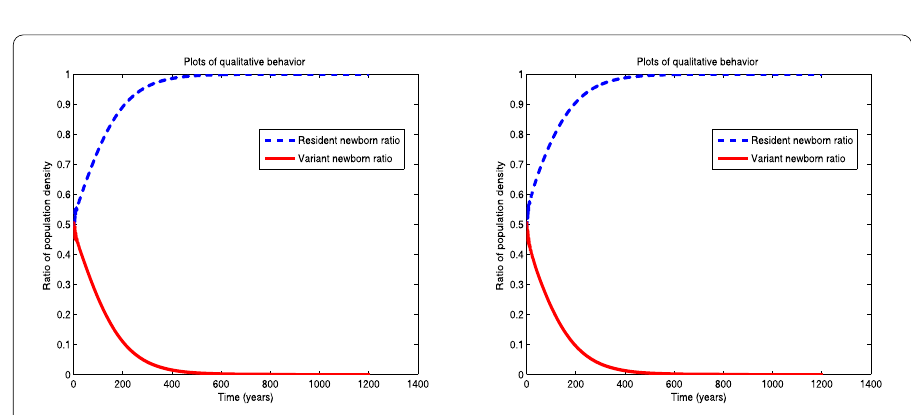
Figure 10 Region IVb. Plot of newborn population ratios vs time. Parameters: h 2 = 0.5, h 3 = 0.7 on the left h 1 = 0 and on the right h 1 =